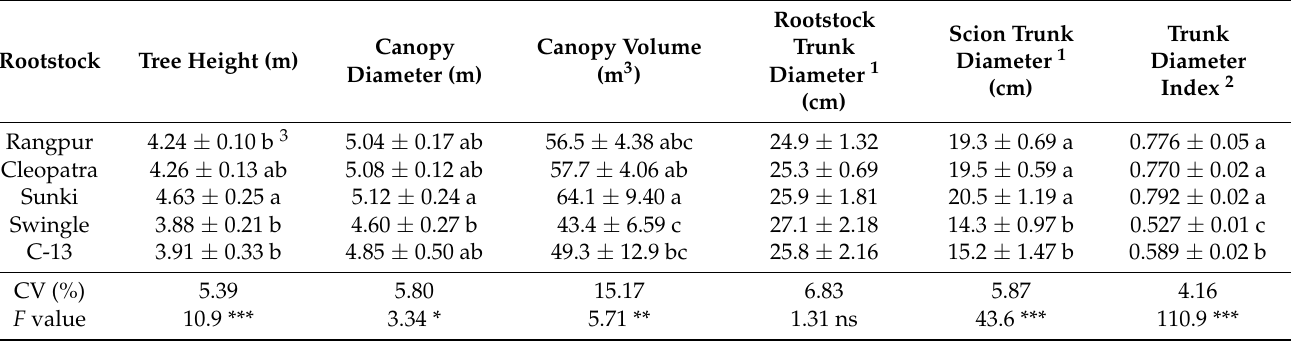
Table 1. Tree size of ‘Shamouti’ sweet orange grafted on different rootstocks grown in Londrina, state of Paraná, Brazil. Means were based on the 2016–2017 seasons.